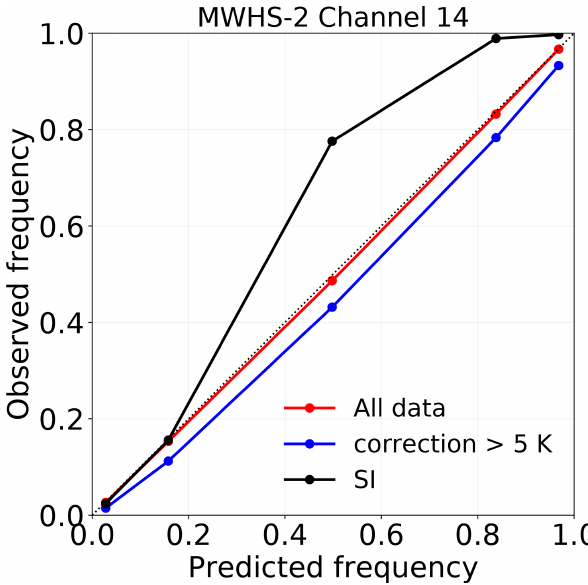
Figure 7. Calibration of the prediction intervals derived from QRNN-single (89 + 150GHz) for MWHS-2 channel 14 and predic- tion intervals derived from Gaussian error model for the ECMWF NWP system (SI). For the former, the calibrations for both the en- tire predicted dataset and the subset with correction greater than 5K are shown.